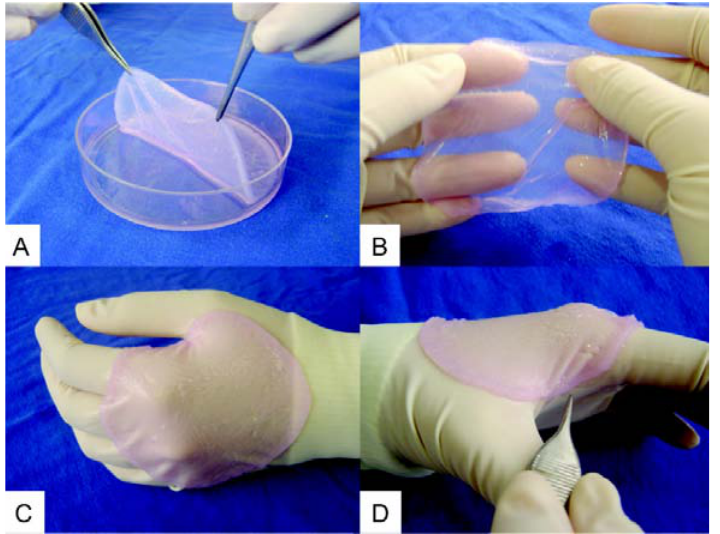
FIGURE 1 - Fibrin substrate. ( A ). Detachment. ( B ). Original size maintenance. ( C ). Transparency and elasticity. ( D ). Easy